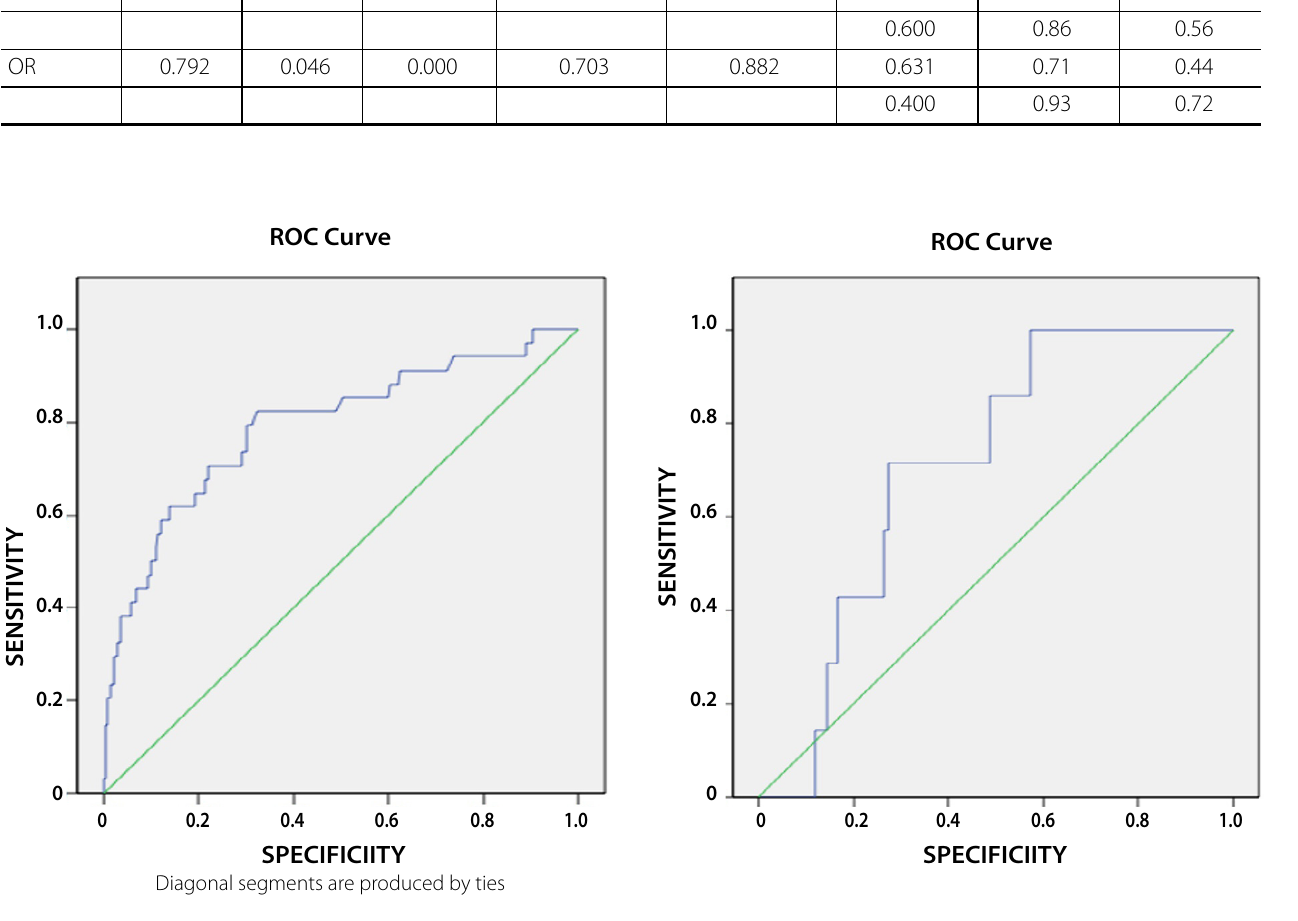
Fig. 5 - ROC curve for PRS versus survival in OR. Fig. 6 - ROC curve for PRS versus survival in EVAR.